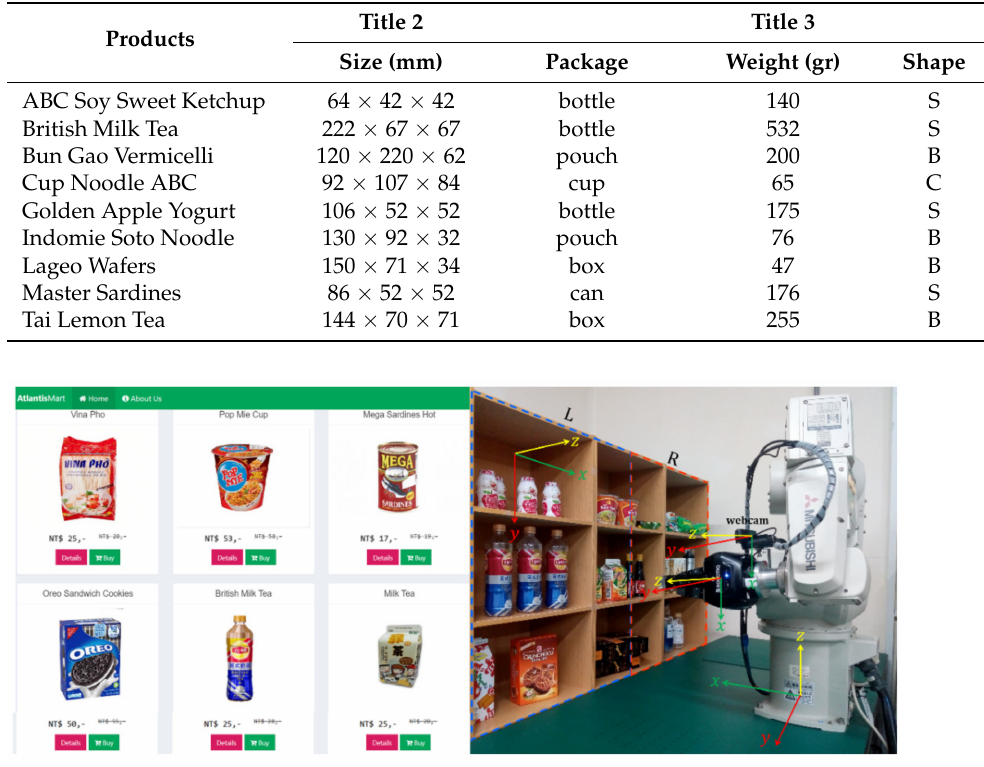
Table 1. The characteristics of the products sold in our shop.